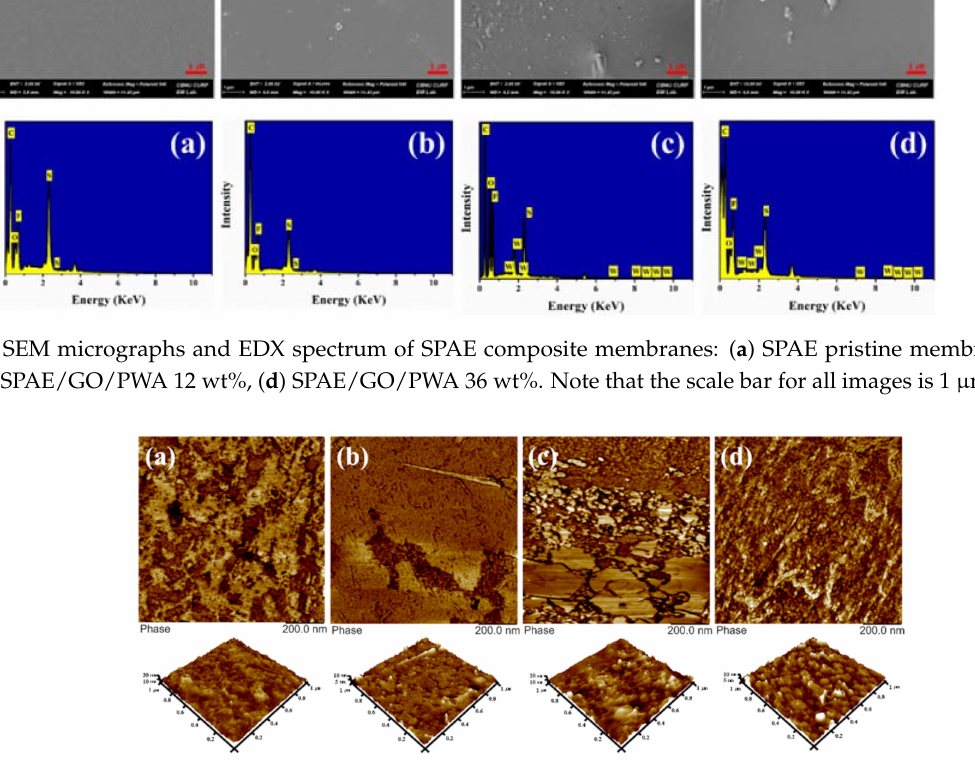
Figure 7. AFM phase and 3D images of the SPAE composite membranes under 100% RH: ( a ) SPAE pristine membrane, ( b ) SPAE/GO, ( c ) SPAE/GO/PWA 12 wt%, ( d ) SPAE/GO/PWA 36